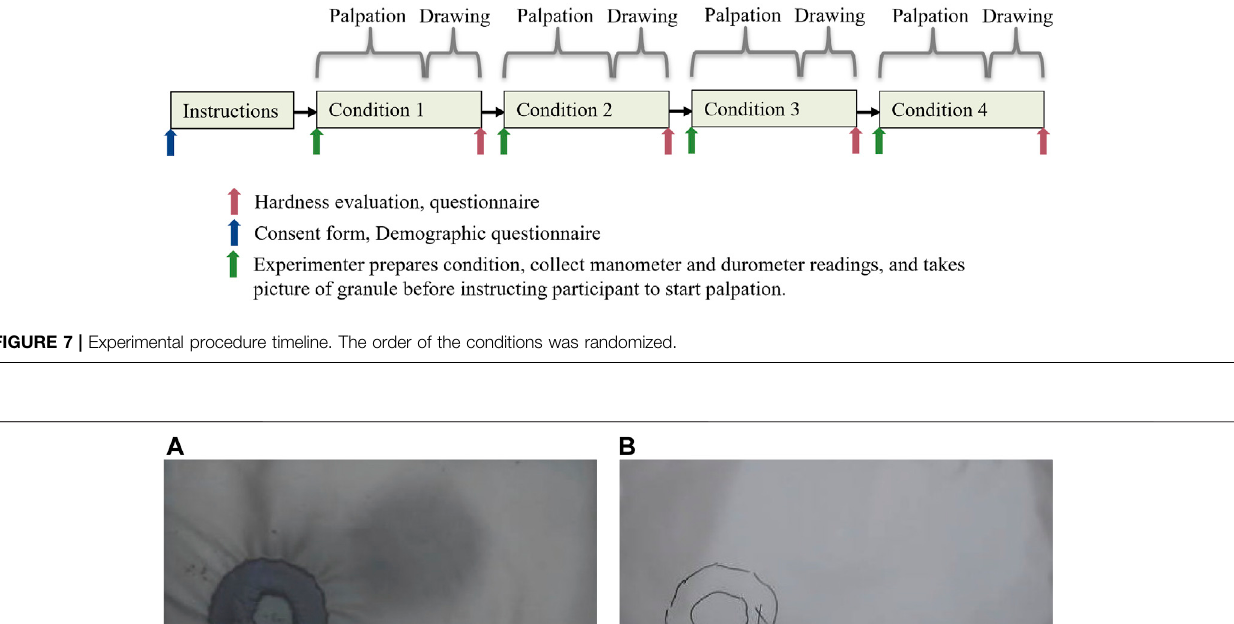
Frontiers in Robotics and AI |